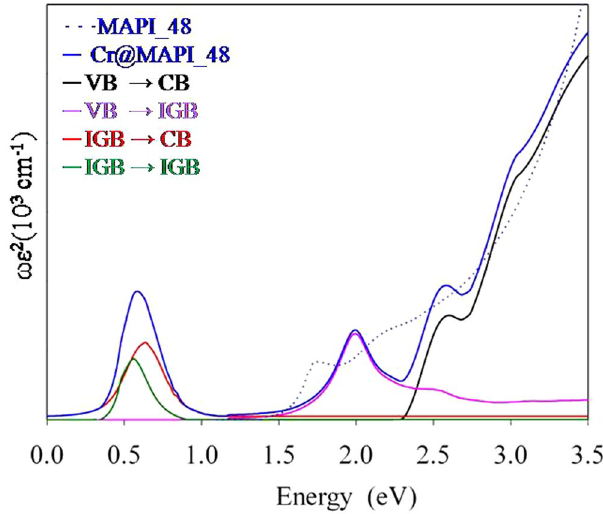
Figure 6. Imaginary part of the dielectric function ε (2) , multiplied by the frequency ω , for MAPI_48 and Cr@MAPI_48 compounds. Partial contributions due to VB-CB, VB-IGB, IGB-CB and IGB - IGB electronic transitions for Cr@MAPI_48 have been also